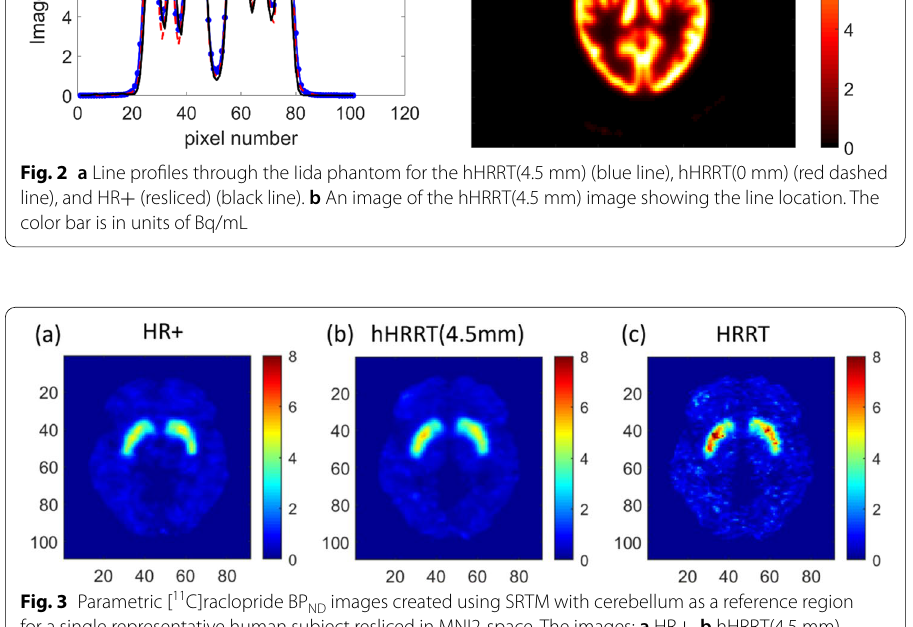
Experiment 3: Comparison of calculated endpoint with Test–Retest Data from HR